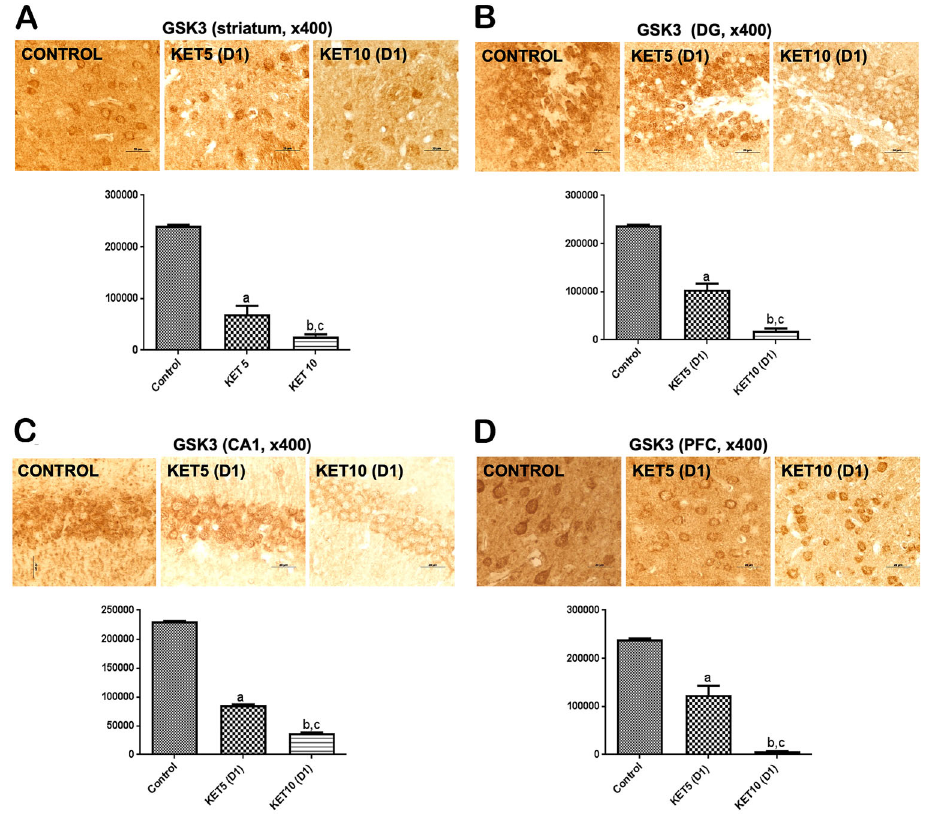
Figure 3. Single administrations of ketamine (KET, 5 and 10 mg/kg, ip ) signi fi cantly reduced glycogen synthase kinase (GSK-3) immunoreactivities in A ) striatum, B ) dentate gyrus (DG), C ) CA1 hippocampal sub fi eld, and D ) prefrontal cortex (PFC), in a dose- dependent manner compared with controls (3 animals per group). Representative photomicrographs, at (cid:1) 400 magni fi cation (scale bar: 20 m m), taken at day 1 (D1) protocol. The graphs show the relative absorbance determined by ImageJ software (NIH, USA). Data are reported as means ± SE. a,b P o 0.01 vs Control; c P o 0.01 vs KET 5 (one-way ANOVA and Tukey as the post hoc